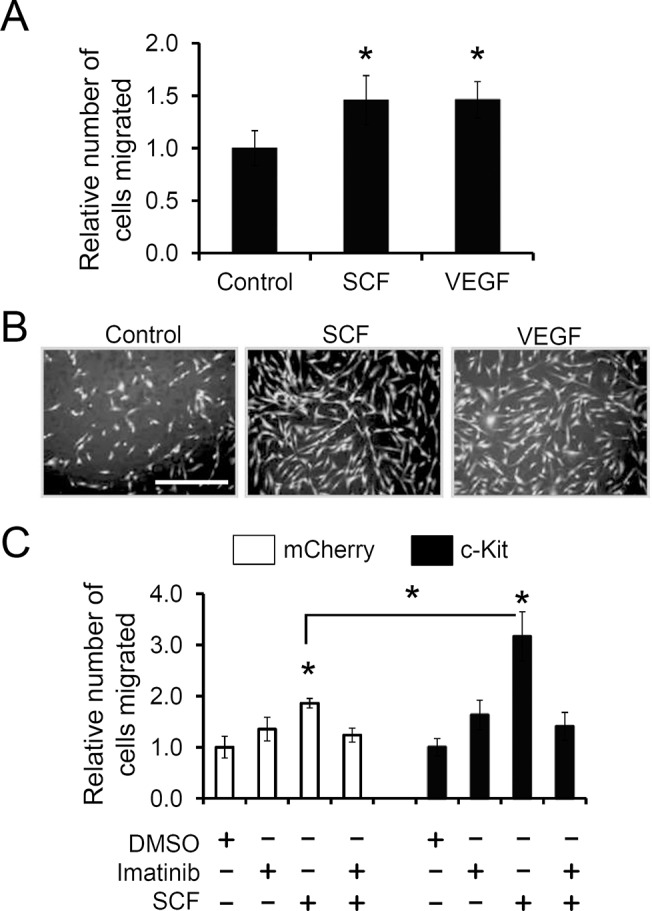
c-kit activation promotes migration of CPCs.Boyden chamber assay. Human c-kit+ CPCs were plated in the upper chamber, and the indicated growth factors were used as a chemoattractant in the lower chamber. After 24 hr, the migrated cells were fixed, stained with propidium iodide, and counted. A, Comparison of the pro-migratory effect of SCF and VEGF. B, Representative images showing the cells that migrated towards the indicated growth factors. C, CPCs transduced with lentivirus expressing mCherry (control) or c-kit were compared for their chemotaxis towards SCF in the presence (+) or absence (-) of 0.5 mM imatinib. Values presented are mean ± SEM. *, p<0.05.